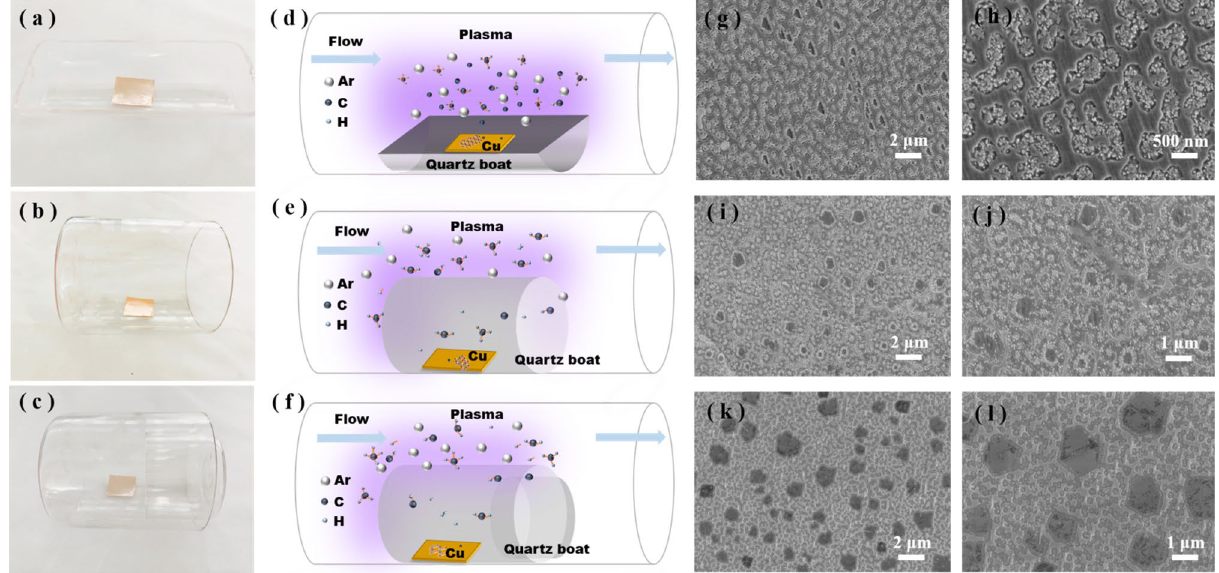
Figure 2. ( a – c ) Images of different quartz boat placements for graphene growth on Cu. ( d – f ) Schematic diagram of graphene growth with different placement methods. ( g – h ), ( i – j ), and ( k – l ) SEM photographs of graphene growing with placement modes ( a – c ), respectively. Graphene was grown on copper substrate at 850 °C for 60 s with Ar/H